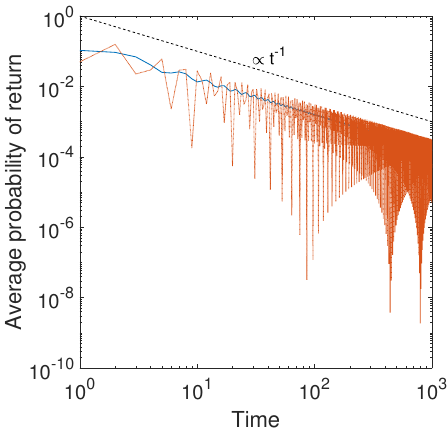
Figure 2. Probability of return for a given vertex of a ring graph with n = 100,001 nodes using combinatorial Laplacian L (red dotted line) and using L s = 2 (blue continuous line). The broken black line indicates the behavior ¯ π ∝ t − 1